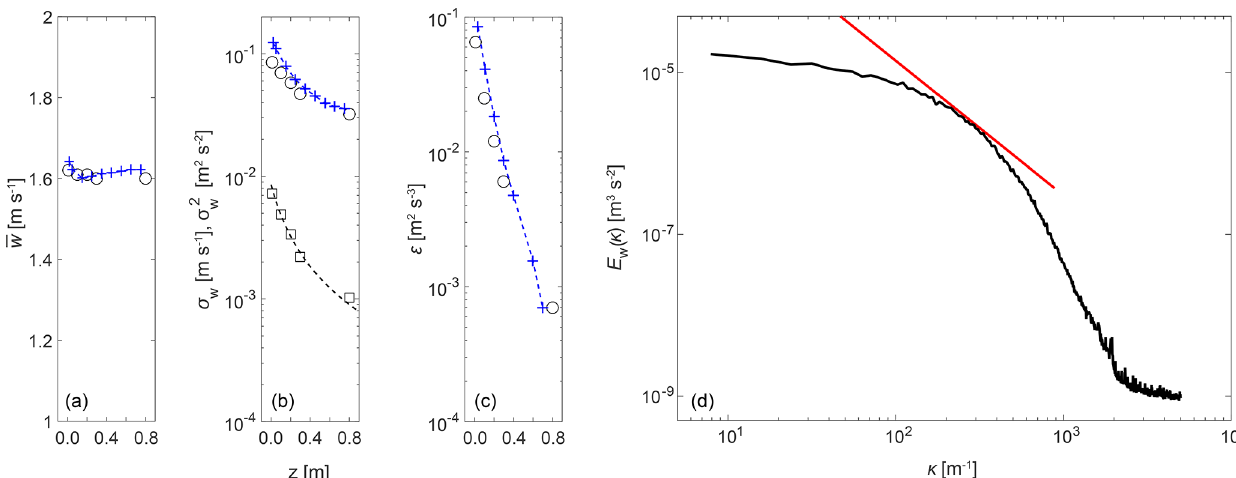
Figure 5. The measurements shown in Fig. 4 were carried out for five different heights below the aerosol inlet. The values for mean velocity, rms velocity and dissipation rate are averaged in the range from − 70 to + 70mm (switched-on aerosol flow) and are shown in (a, b, c) by the black circles. Panel (b) further shows the drop in turbulent kinetic energy in terms of the squared rms velocity (black squares) which follows a power-law function with an exponent of − 1 . 4 (dotted black line). Additionally, the respective results from the simulations are shown (blue plus signs), also averaged in the range from − 70 to + 70mm. The experimentally determined turbulent spectrum for the velocity fluctuations is shown in (d) . A red line with a − 5 / 3 slope is shown as a